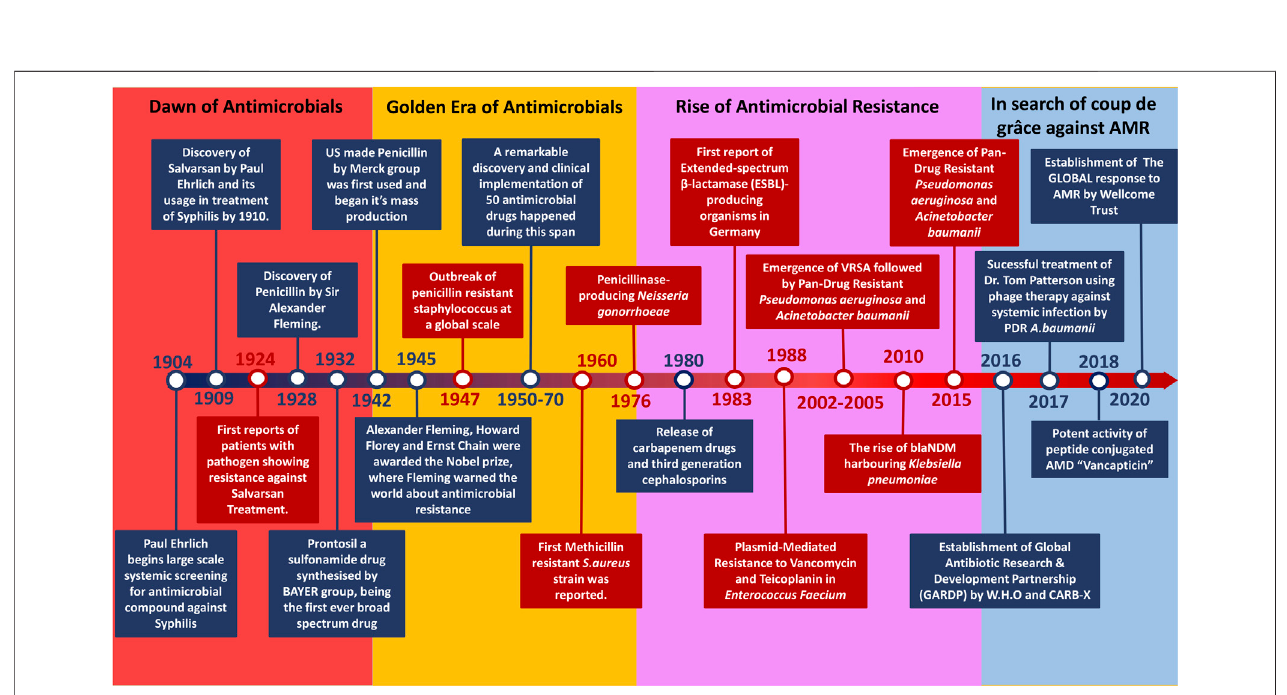
FIGURE 2 | Timeline of events leading to the rise and fall of AMDs across different